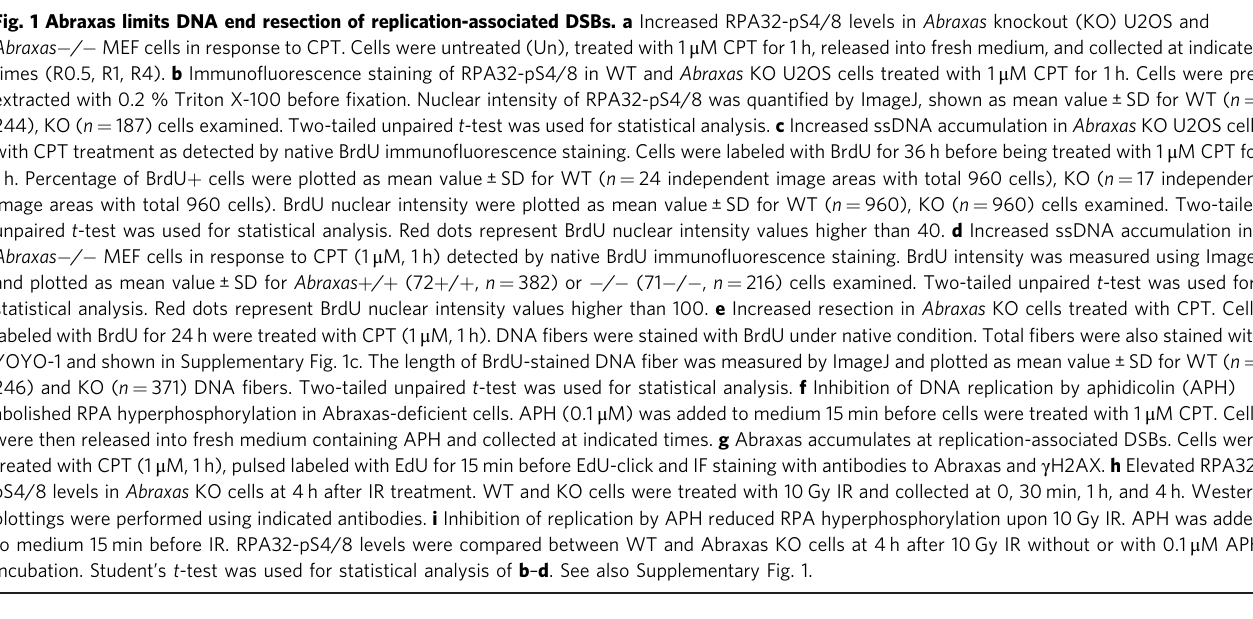
Fig. 1 Abraxas limits DNA end resection of replication-associated DSBs. a Increased RPA32-pS4/8 levels in Abraxas knockout (KO) U2OS and Abraxas − / − MEF cells in response to CPT. Cells were untreated (Un), treated with 1 μ M CPT for 1 h, released into fresh medium, and collected at indicated times (R0.5, R1, R4). b Immuno fl uorescence staining of RPA32-pS4/8 in WT and Abraxas KO U2OS cells treated with 1 μ M CPT for 1 h. Cells were pre- extracted with 0.2 % Triton X-100 before fi xation. Nuclear intensity of RPA32-pS4/8 was quanti fi ed by ImageJ, shown as mean value ± SD for WT ( n = 244), KO ( n = 187) cells examined. Two-tailed unpaired t -test was used for statistical analysis. c Increased ssDNA accumulation in Abraxas KO U2OS